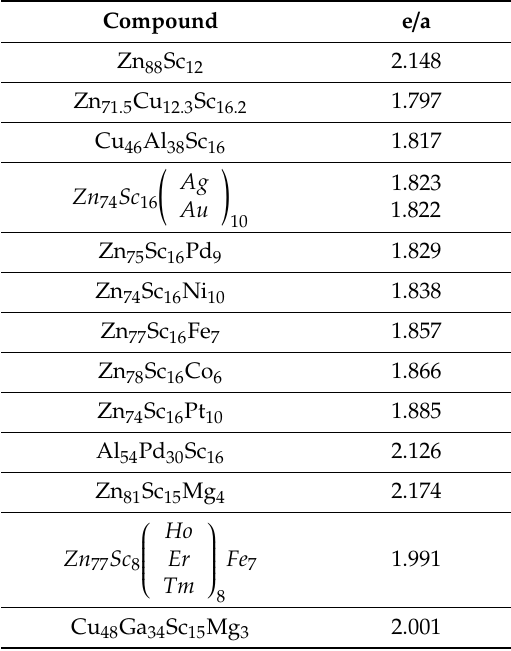
Table 2. Sc bearing icosahedral quasicrystals (i-QCs) belonging to di ff erent alloy systems grouped by their electron-per-atom e / a ratio value